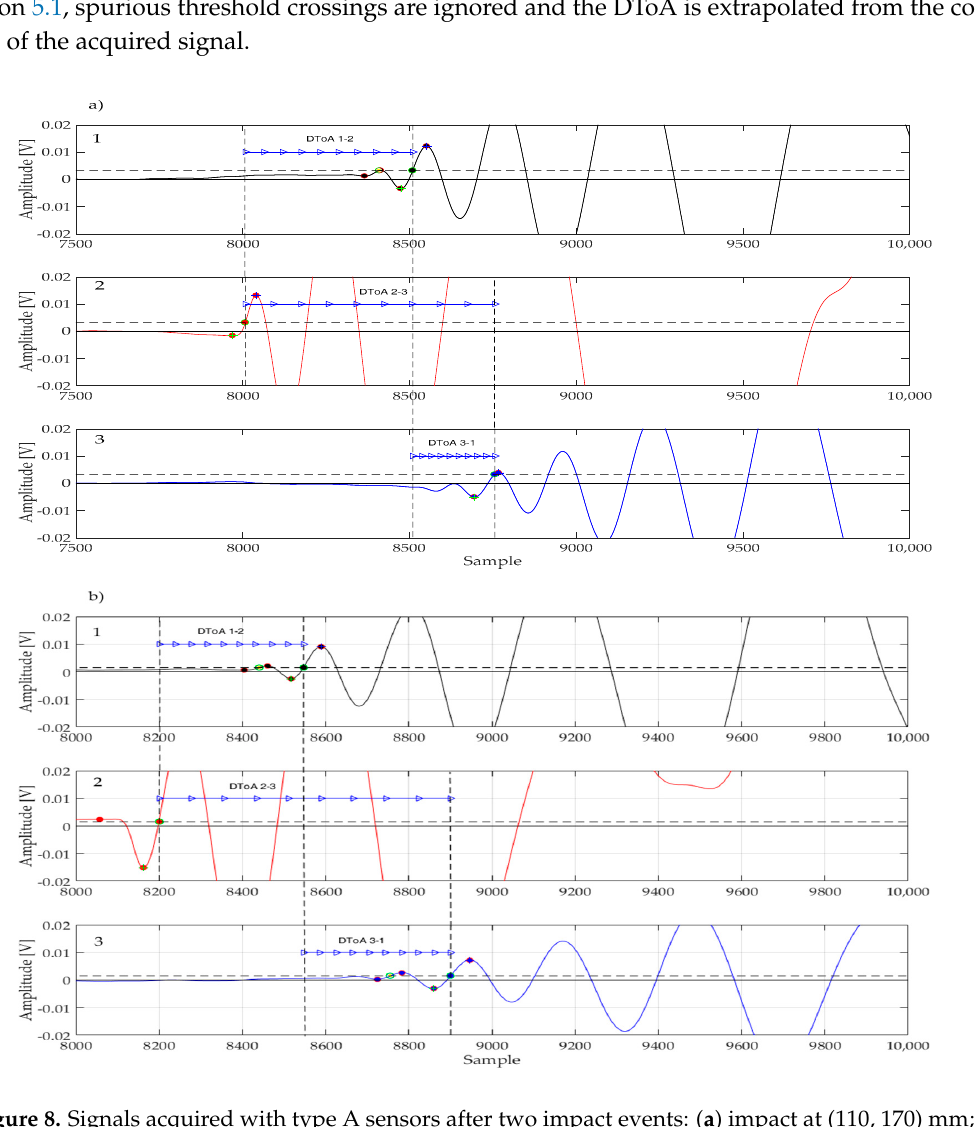
Figure 8. Signals acquired with type A sensors after two impact events: ( a ) impact at (110, 170) mm; ( b ) impact at (230, 170) mm. The sampling rate was 10 MSps.